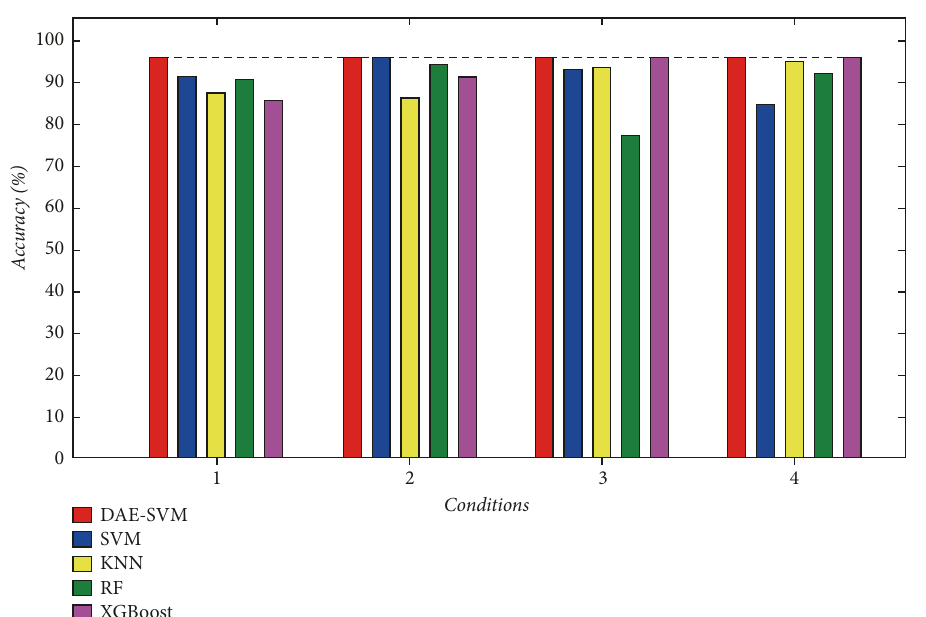
Figure 16: Classification accuracy of 4 conditions using different